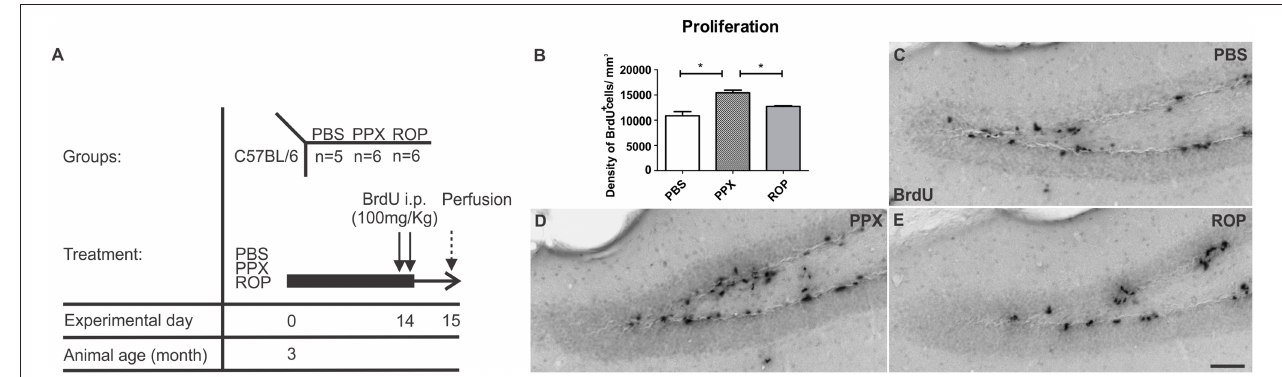
FIGURE 2 | Increased cell proliferation in the murine DG after chronic administration with PPX, but not after ROP treatment. (A) Proliferation paradigm. 3-month-old C57BL/6 received either i.p. PPX, ROP or PBS for 14 days. At day 14, animals were i.p. injected with BrdU (100mg/kg) twice to label proliferating cells. Mice were perfused at day 15. (B) Quantification of BrdU + cells in the DG revealed an increased density of proliferating cells after PPX compared to ROP and PBS. Representative stainings of BrdU + cells in the DG of PBS- (C) , PPX- (D) , and ROP-injected animals (E) . Error bars represent mean ± SEM. One-way ANOVA followed